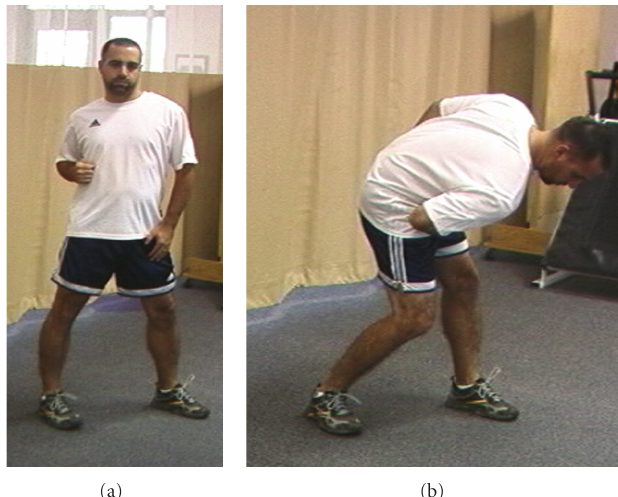
Figure 4: (a) Facilitation of scapular retraction: hip and trunk extension facilitates scapular retraction. (b) Facilitation of scapular protraction: hip and trunk flexion facilitate scapular protraction.